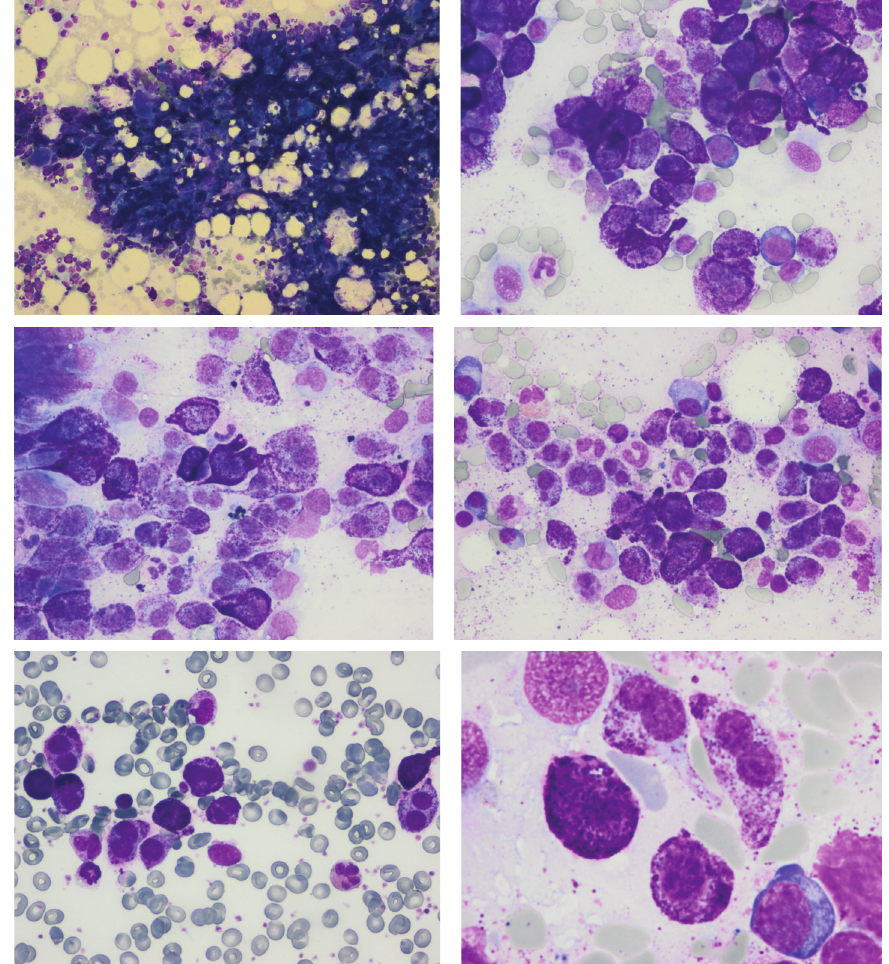
Figure 1: Bone marrow smears at the time of diagnosis (stained by May-Grunwald and Giemsa). Atypical mast cells presented alterations in size and in shape; they presented often with few or numerous metachromatic granules and often contained bilobed